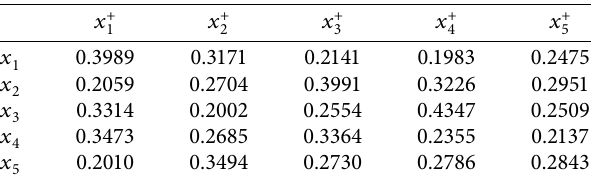
Table 3: Distance set between attribute values of each scheme and corresponding values of PIS.